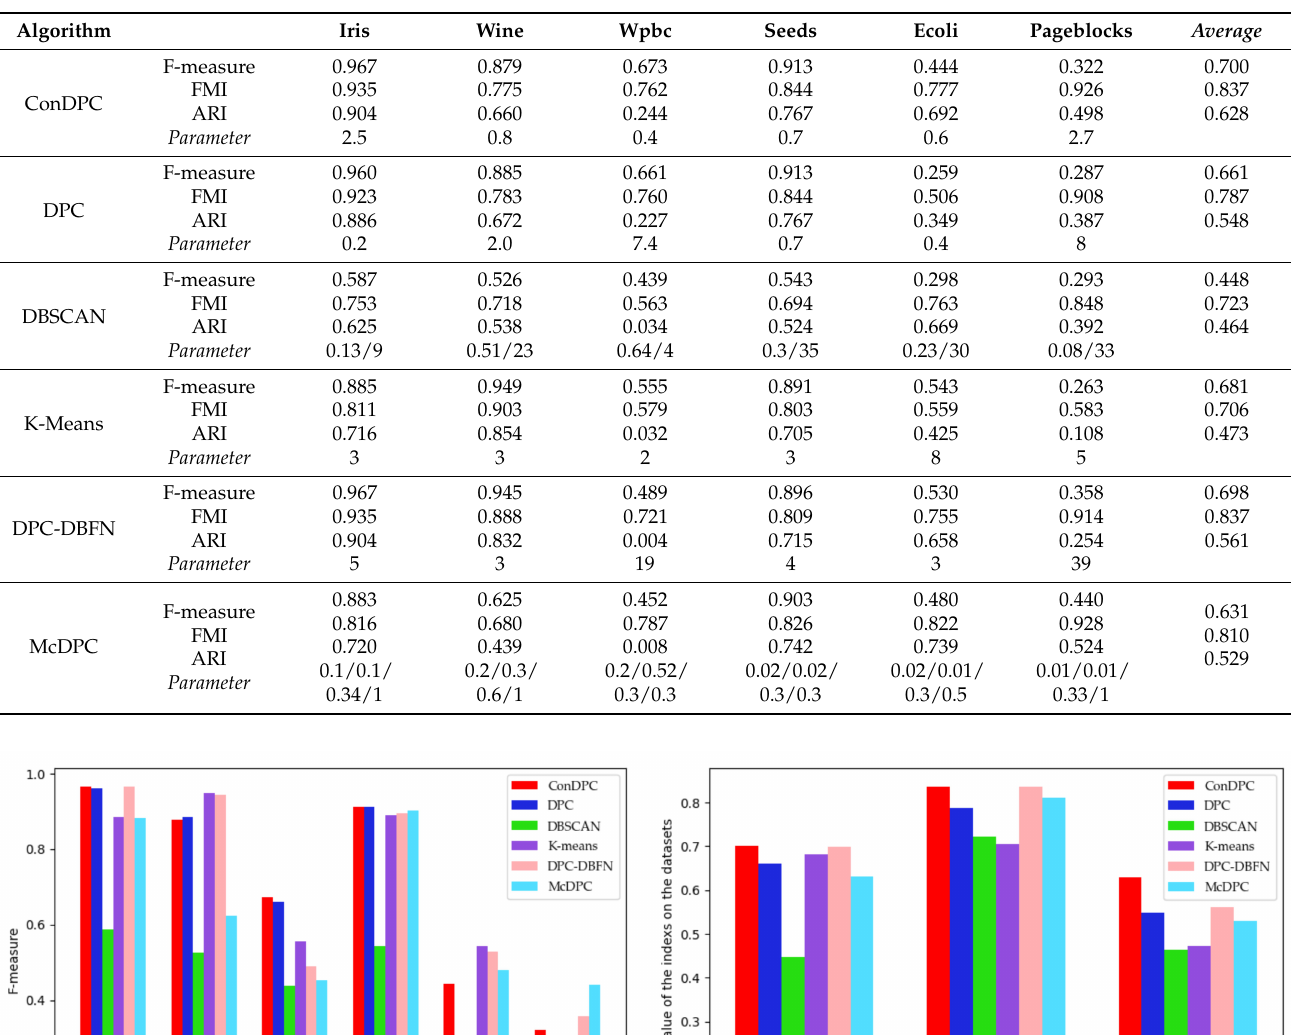
Table 5. Performances on real-world datasets.